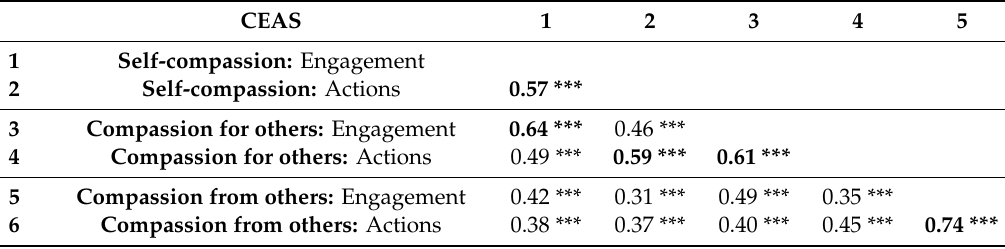
Table 6. Correlation of the compassion subscales (n = 788).